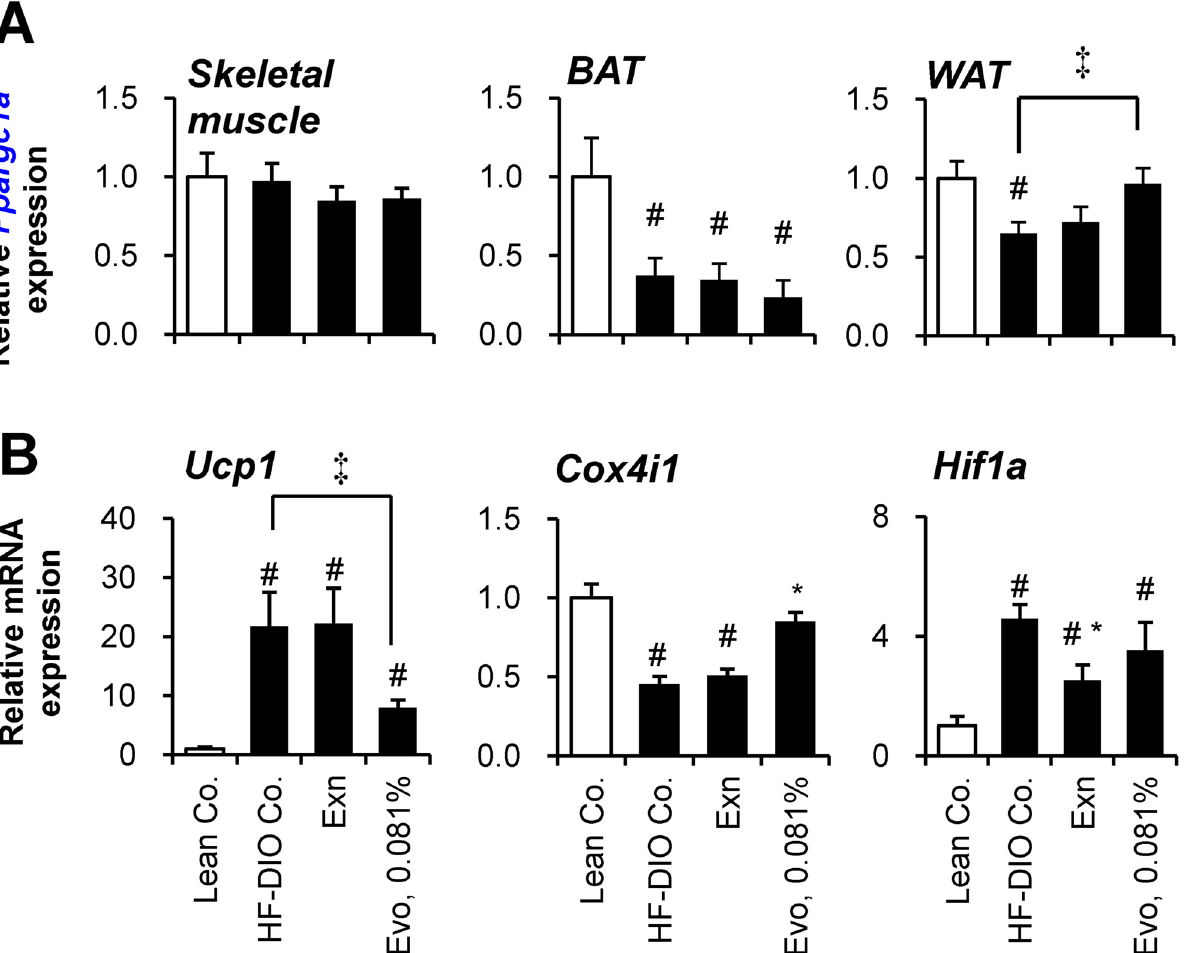
Fig 6. Effect of evogliptin treatment on the gene expression in muscle and adipose tissues. After 2 – week administration of exenatide (30 μ g kg -1 , once daily, s.c.) or evogliptin at 0.081% (w/w) in HF-DIO mice, (A) PGC-1 α ( Ppargc1a ) gene expression in soleus muscle and two types of fat tissues (interscapular fat and epididymal fat for brown adipose tissue and white adipose tissue, respectively), and gene expression levels of (B) UCP1 ( Ucp1 ), (C) COXIV ( Cox4i1 ) and HIF-1 α ( Hif1a ) were assessed in white adipose tissue by realtime qPCR method (n = 8/group). #, P < 0.05 vs. lean control and * , P < 0.05 vs. HF-DIO control by one-way ANOVA; ‡ , P < 0.05 by Student ’ s